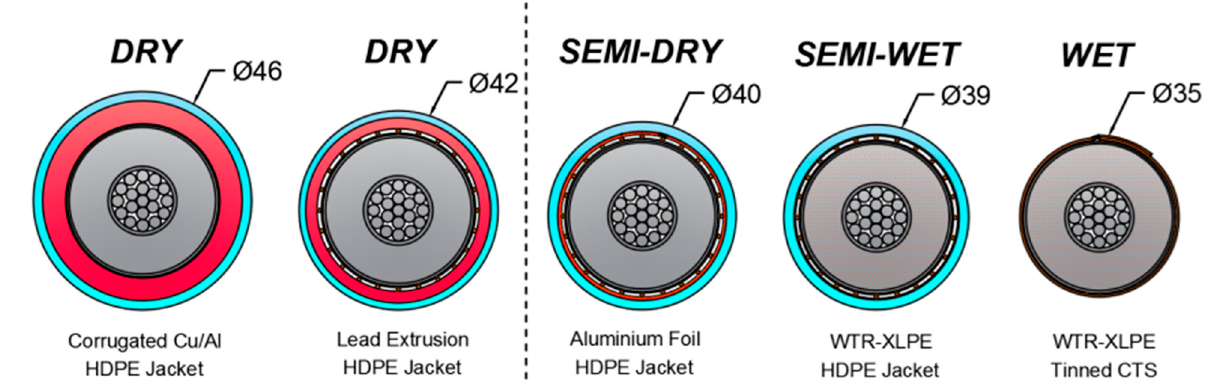
Figure 2. Types of cables according to the type of radial water barriers.